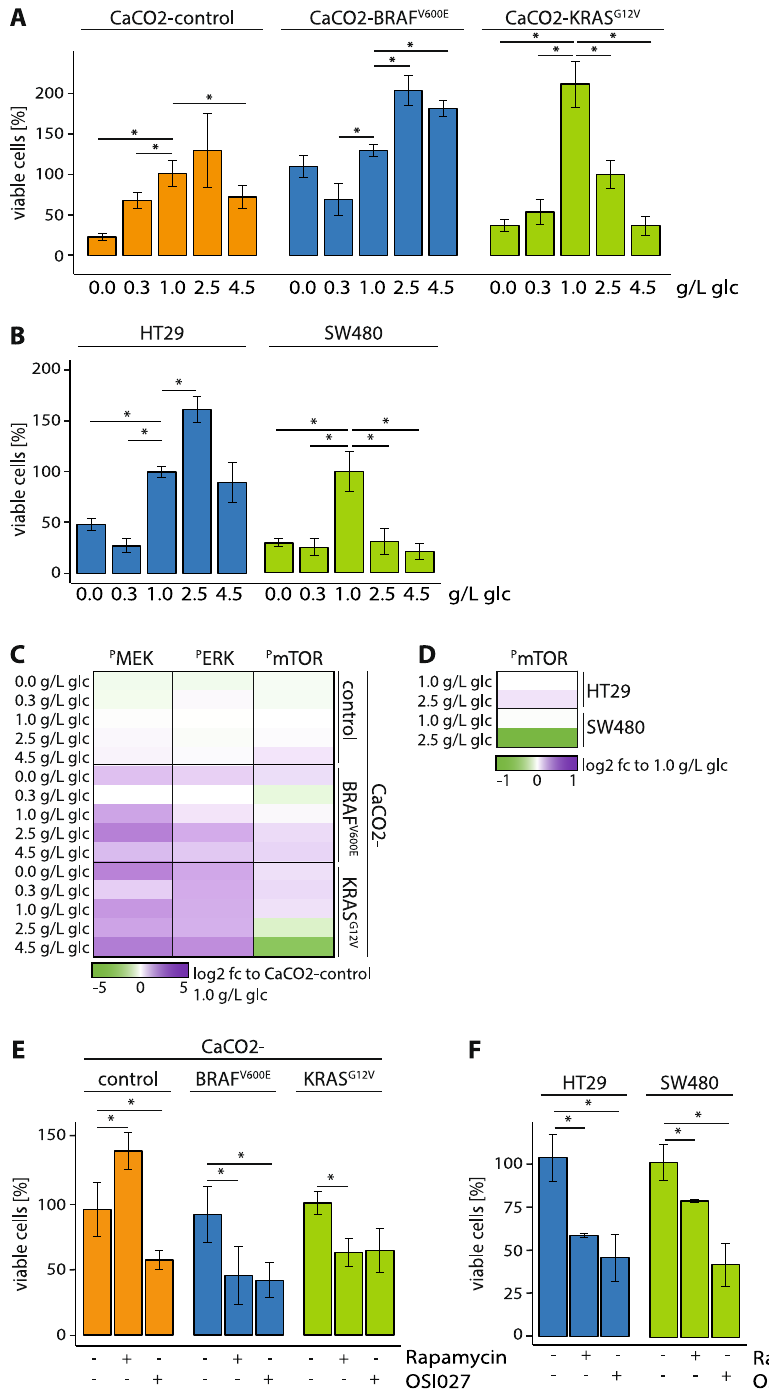
Figure 2. BRAF V600E and KRAS G12V induced glucose-dependent proliferation and alterations of signaling to mTOR. ( A , B ) CaCO2-control, CaCO2-BRAF V600E , CaCO2-KRAS G12V , HT29 and SW480 cells were cultivated with indicated glucose concentrations. Shown are viable cells (A: normalized to CaCO2-control cells 1.0 g/L glucose and B: normalized to 1.0 g/L glucose per cell line). Shown are standard deviation of (in minimum) n = 3 replicates. p < 0.05 was indicated with asterisk (unpaired two-tailed t Test). ( C , D) Phosphorylation of signaling molecules were analyzed with ELISA bead-based phosphoproteomics technology (Luminex). Shown are log2 fold changes (fc, A: normalized to CaCO2-control cells 1.0 g/L glucose and B: normalized to 1.0 g/L glucose per cell line) of (in minimum) n = 3 replicates. ( E , F) CaCO2-control, CaCO2-BRAF V600E , CaCO2-KRAS G12V , HT29 and SW480 cells grown in physiological (1.0 g/L) glucose concentrations were treated with 10 µ M Rapamycin and 10 µ M OSI027 ( + ) or DMSO ( − ) for 24 h. Viable cells compared to DMSO are depicted. glc: glucose. Shown are standard deviation of (in minimum) n = 3 replicates. p < 0.05 was indicated with asterisk (unpaired two- tailed t